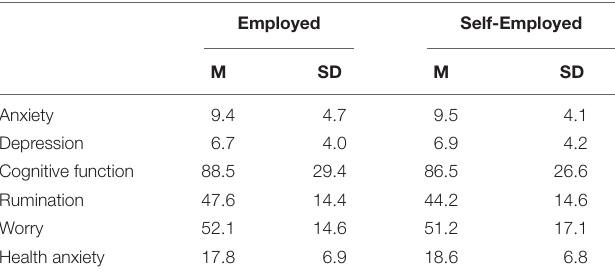
TABLE 2 | Means and standard deviations for symptomology